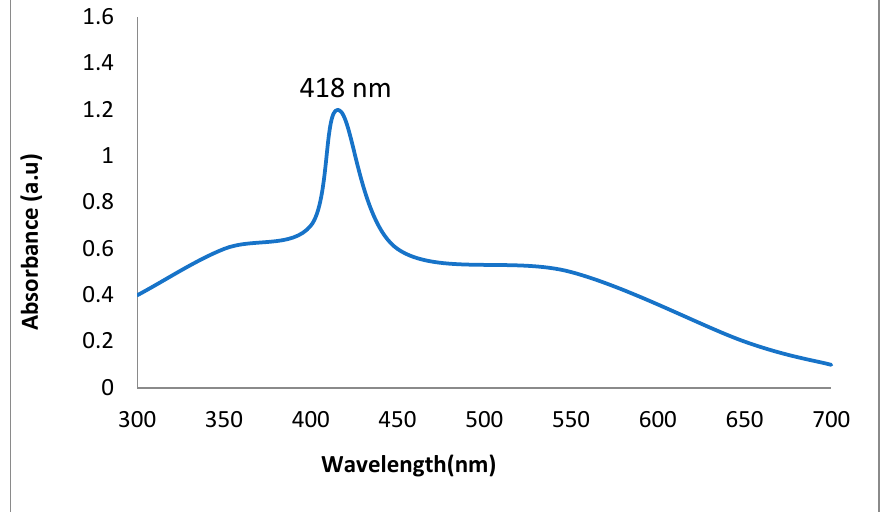
Figure 2. UV – vis spectroscopy of AgNPs. SEM was used to performthe structural quantification of plant-mediated AgNPs. Green-synthesized AgNPs were spherical, cylindrical, or rectangular in shape, with an average size of 74 nm, as demonstrated in the SEM image (Figure 3). Some of these particles, however, were irregular and anisotropic in shape.